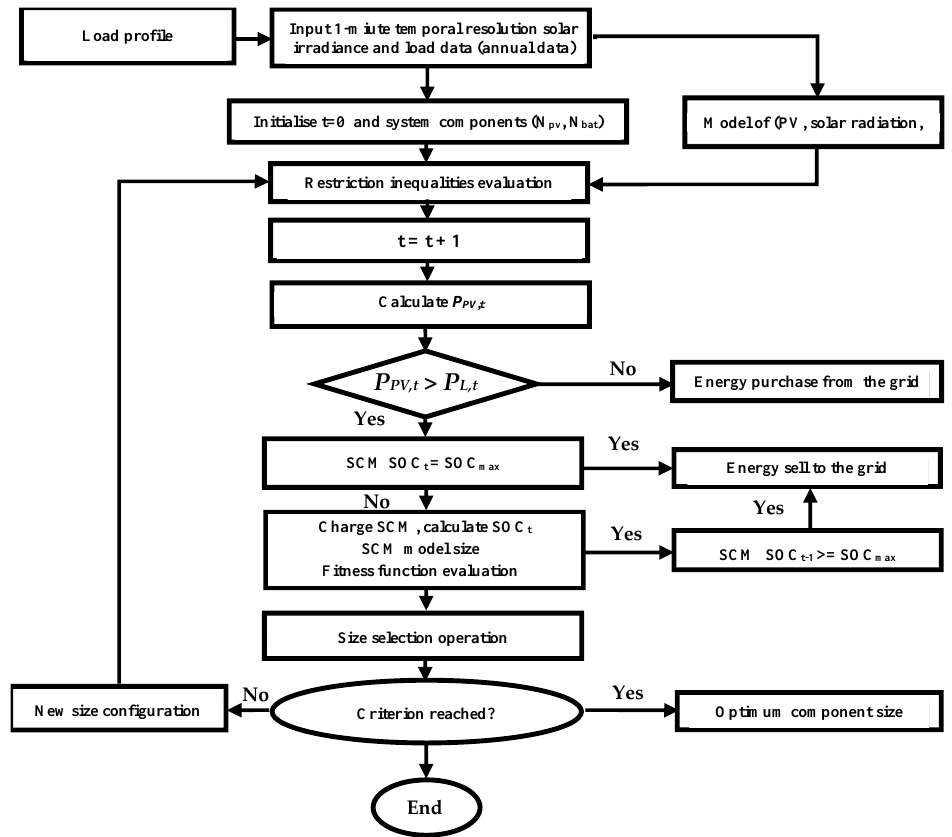
Figure 5. Process flowchart of the energy system simulation.